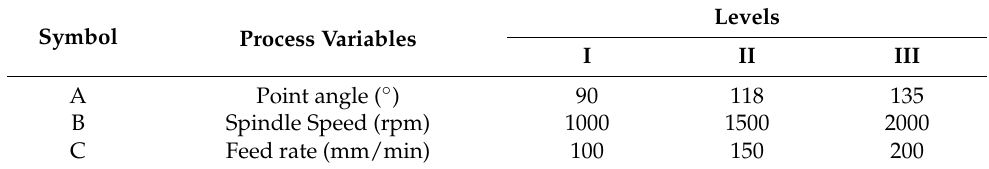
Table 2. Process variables and their levels.